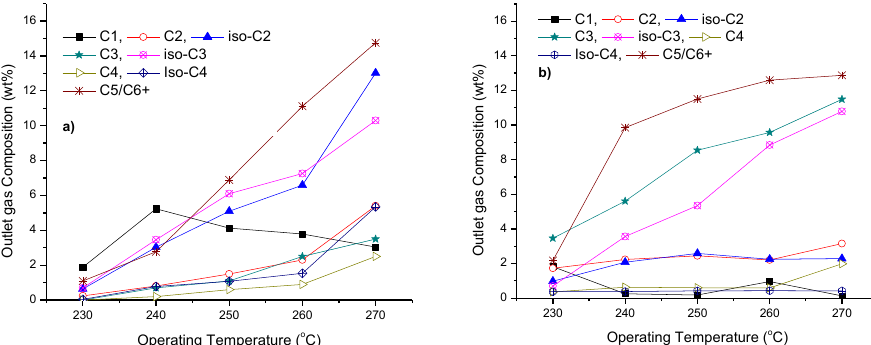
Figure 5. Outlet gas at P = 50 bar, LHSV = 1 h –1 & GHSV = 1180 mln/(g.cat).h, for different temperature in Pt-Cl / H - β . ( a ) feed as n-C 16 and ( b ) feed as 10 H-ULSD (note: Mass balance calculated based hydrocarbons and H 2 in outlet concentration) (lines to guide eye).